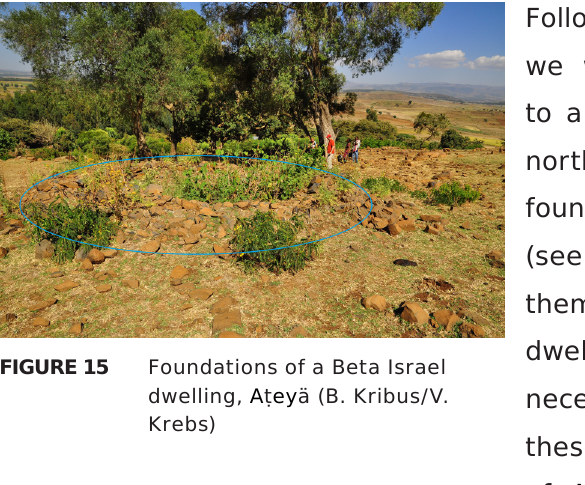
FIgure 15 Foundations of a Beta Israel dwelling, A ṭ eyä (B. Kribus/V.